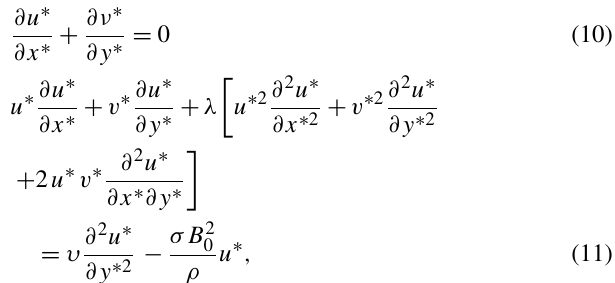
Figure 2. The (cid:125) 1 – validity for M = 0, De = 0.4, Re w = 5 and Pr = 0.9 given by the 4, 5, 6 and 7th-order